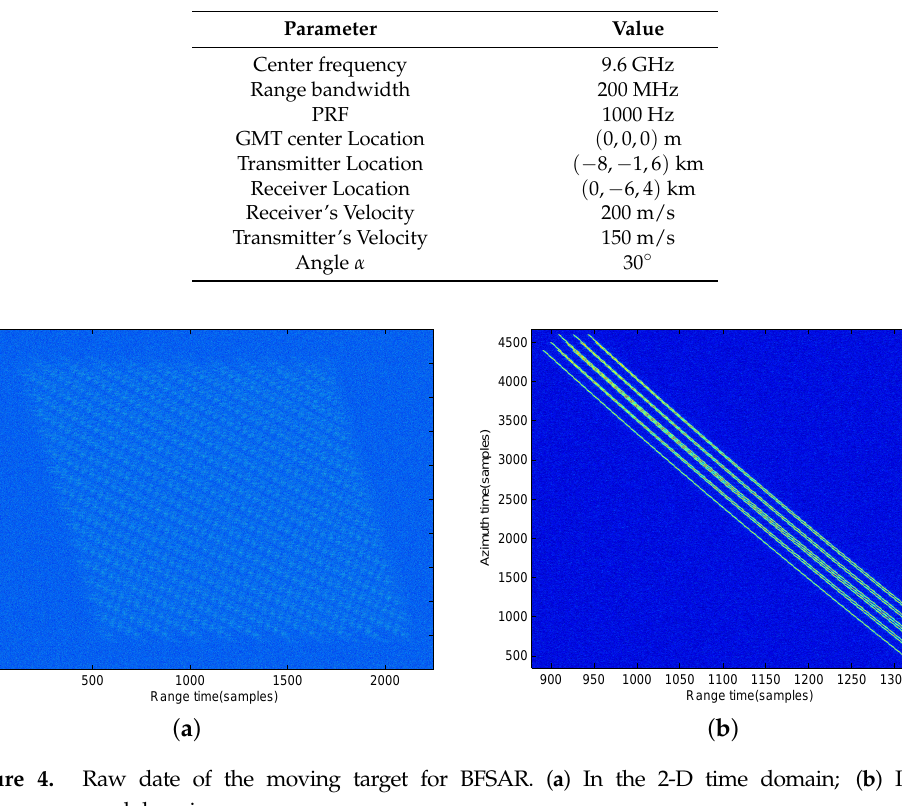
Table 1. Relevant Parameters of the Simulations.